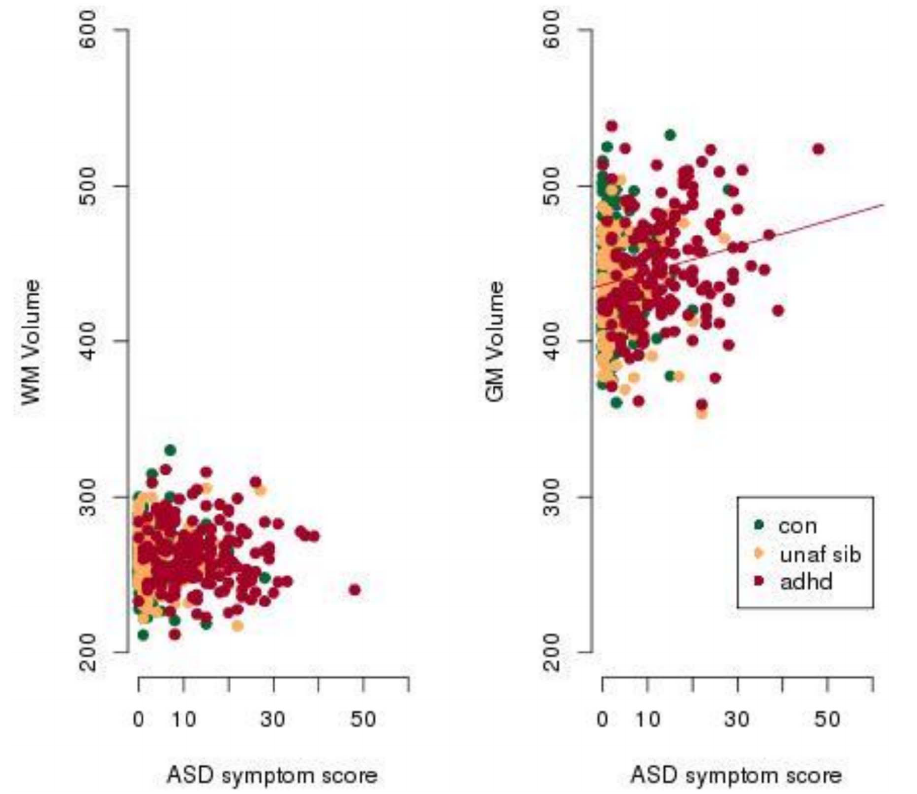
Figure 2. ASD scores are significantly positively correlated with total grey matter volume. The volumes of grey and white matter are normalised for total intracranial volume. A regression line is plotted where the Pearson’s product-moment correlation is significant with p , 0.05. ASD symptom score refers to an aggregate score from the four Children’s Social and Behavioural Questionnaire (CSBQ) subscales, (1) social interest, (2) social understanding, (3) stereotypy and (4) resistance to change. Abbreviations: con, Control; unaf sib, Unaffected Siblings, adhd, Attention Deficit Hyperactivity Disorder; ASD, autism spectrum disorder. doi:10.1371/journal.pone.0101130.g002 PLOS ONE |